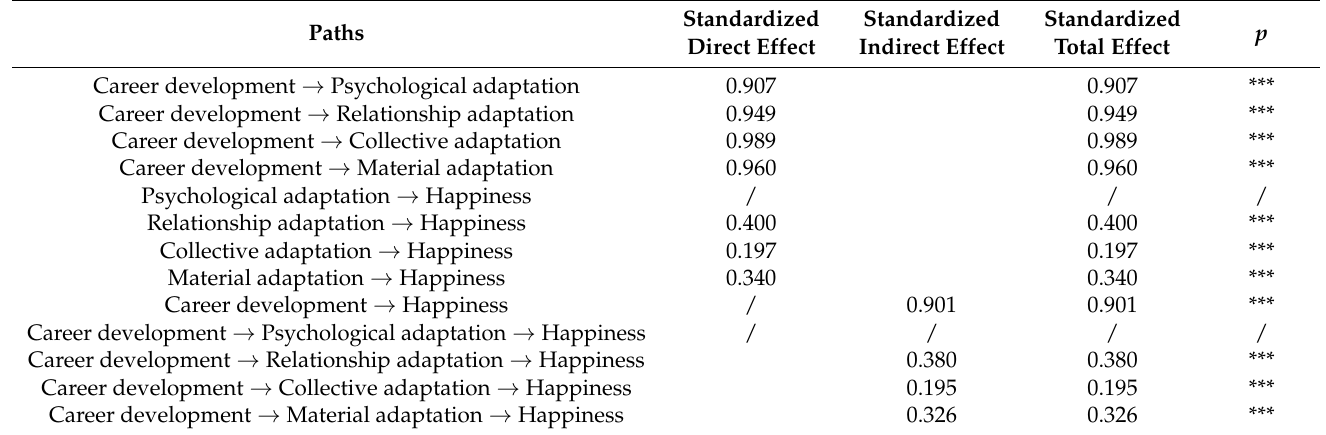
Table 6. The effects of career development on the happiness of urban young returnees.